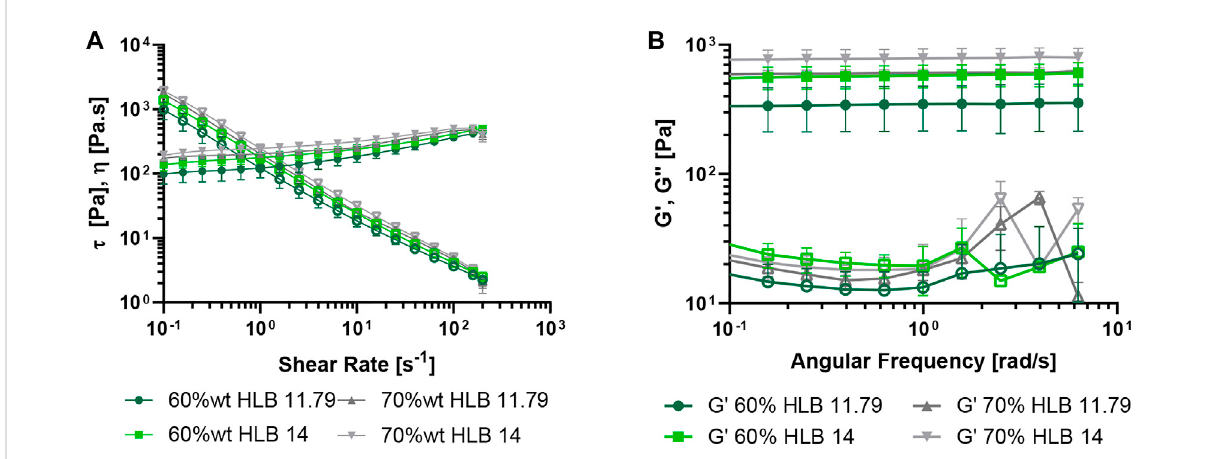
FIGURE 4 Rheological analyses of O/W emulsions at 20 ° C. The emulsions were prepared with the MNPs- PEG8-BUF-II nanobioconjugates at 60% wt., 70% wt., HLB of 11.79 and 14. (A) Shear stress τ vs. shear-rate and viscosity η vs. shear-rate (hollow symbols) at 0.1 – 200 s − 1 . (B) Frequency sweep analyses of O/W emulsions performed at 20 ° C, 1% strain and 0.01 – 1 Hz (hollow symbols correspond to G ″ ).